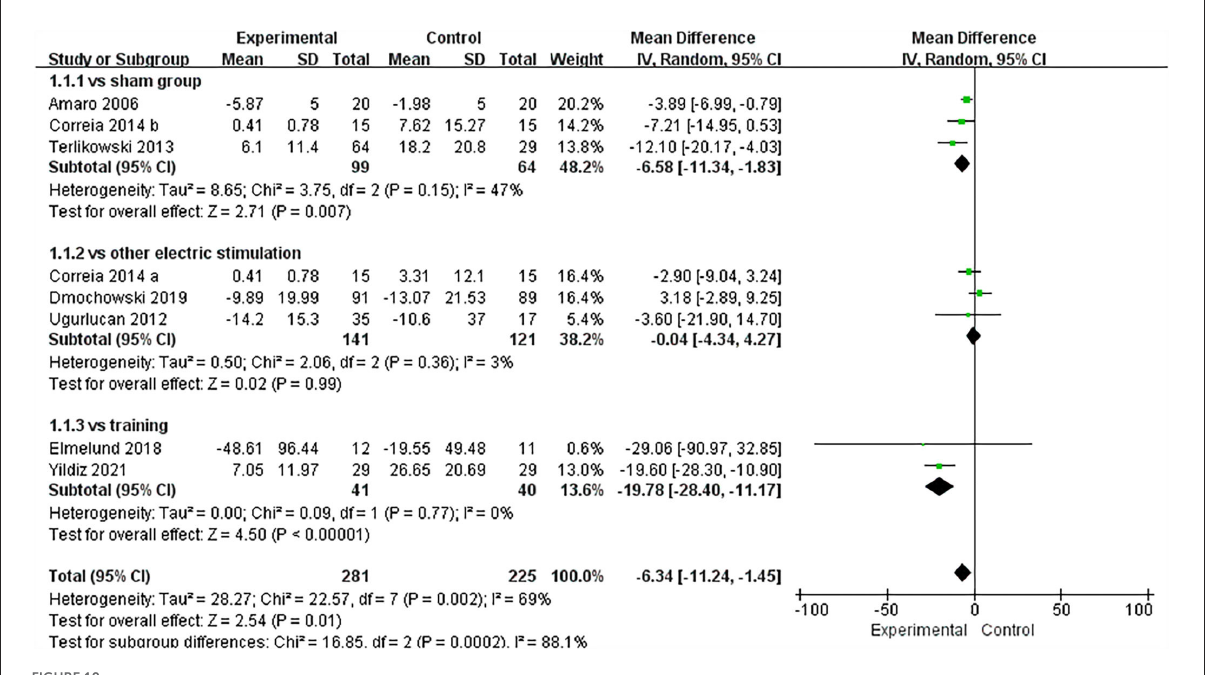
FIGURE10 Forest plots showing the improvement of pad test in each subgroup. SD, standard deviation; IV, inverse variance; CI, confidence interval; df, degrees of freedom.